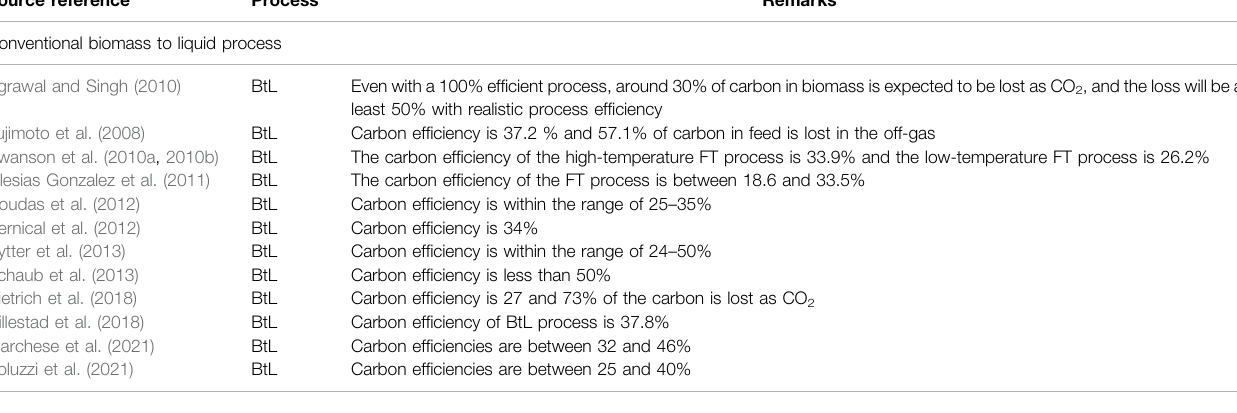
TABLE 1 | Literature survey for BtL process without energy addition.